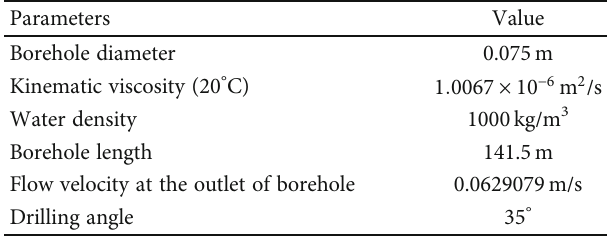
Table 1: Key fl uid parameters of borehole D23-8.